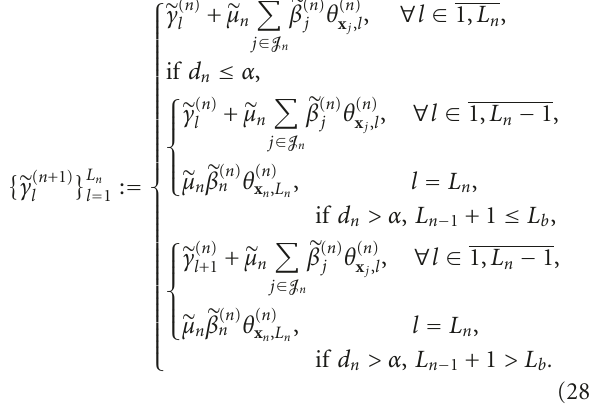
Figure 4: Tracking performance for the channel in Figure 3